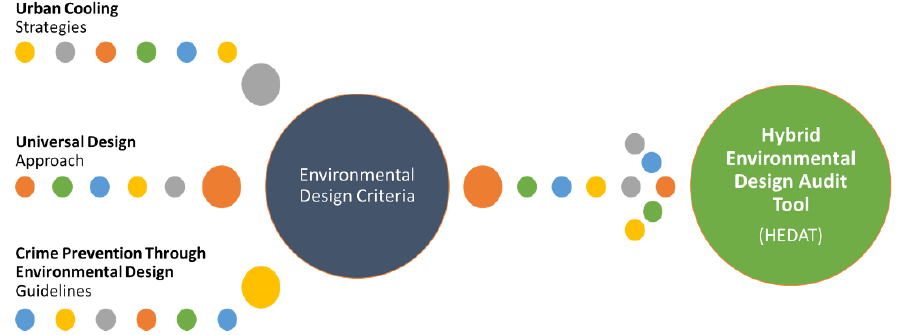
Figure 1. Process used to (1) identify relevant environmental design criteria and (2) develop the HEDAT using well-documented environmental design approaches: Urban Cooling Strategies [19]; UD [57]; and CPTED [58 – 60] (Image Source: Authors).